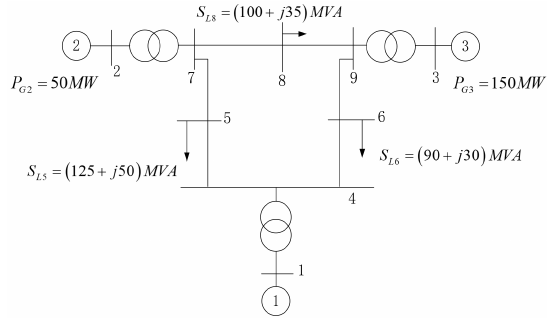
Figure 3. Diagram of 9-buses